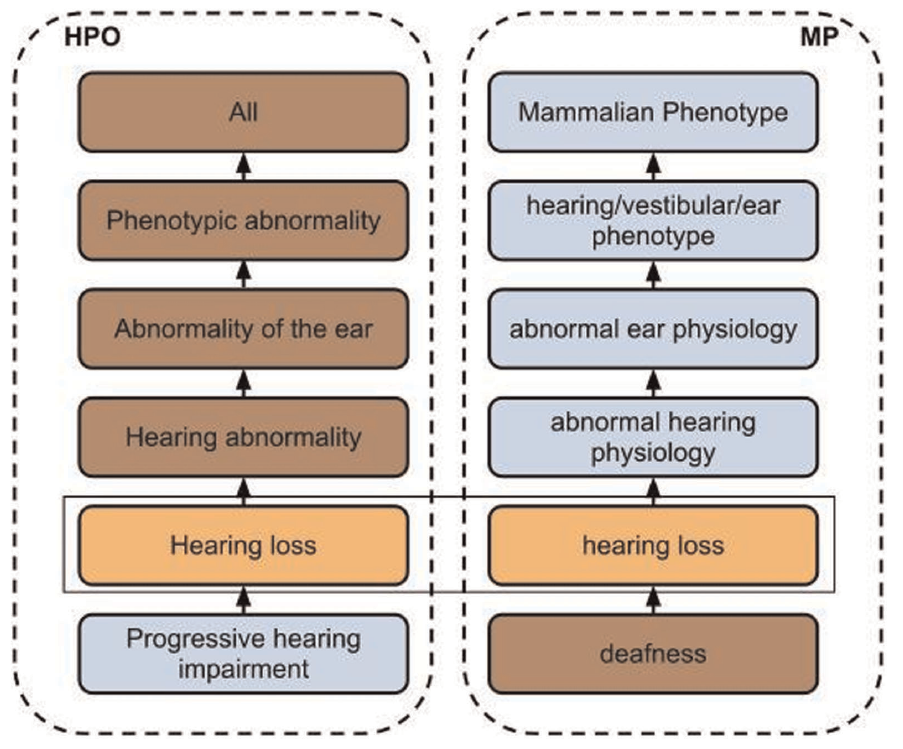
Figure 1. Illustration of an example mapping based on lexical matching. Concepts on the left side belong to HPO and all the concepts on the right side belong to MP. Applying LOOM to both ontologies extracted a lexical match between the HPO concept Hearing loss and the MP concept hearing loss . Based on this lexical match, the HPO concept Hearing loss is declared to be equivalent to the MP concept hearing loss , and the mapping for HPO’s concept Hearing loss will include the MP concepts hearing loss , abnormal hearing physiology , abnormal ear physiology , hearing/vestibular/ear phenotype and Mammalian Phenotype . The HPO concept Progressive hearing impairment will be mapped to the same MP concepts as Hearing loss . Conversely, both the MP concepts hearing loss and deafness are mapped to the HPO concepts Hearing loss , Hearing abnormality , Abnormality of the ear , Phenotypic abnormality and All .